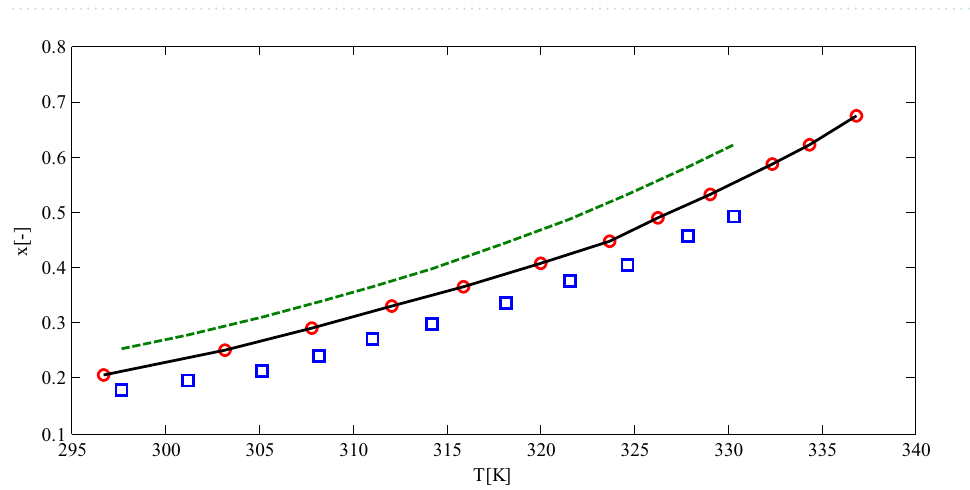
Figure 7. The predictive PC-SAFT EOS solubilities for ibuprofen in octanol (solid line) and ethanol (dashed line) in comparison to experimental data for solubility of ibuprofen in octanol (circle) and ethanol (square) 40